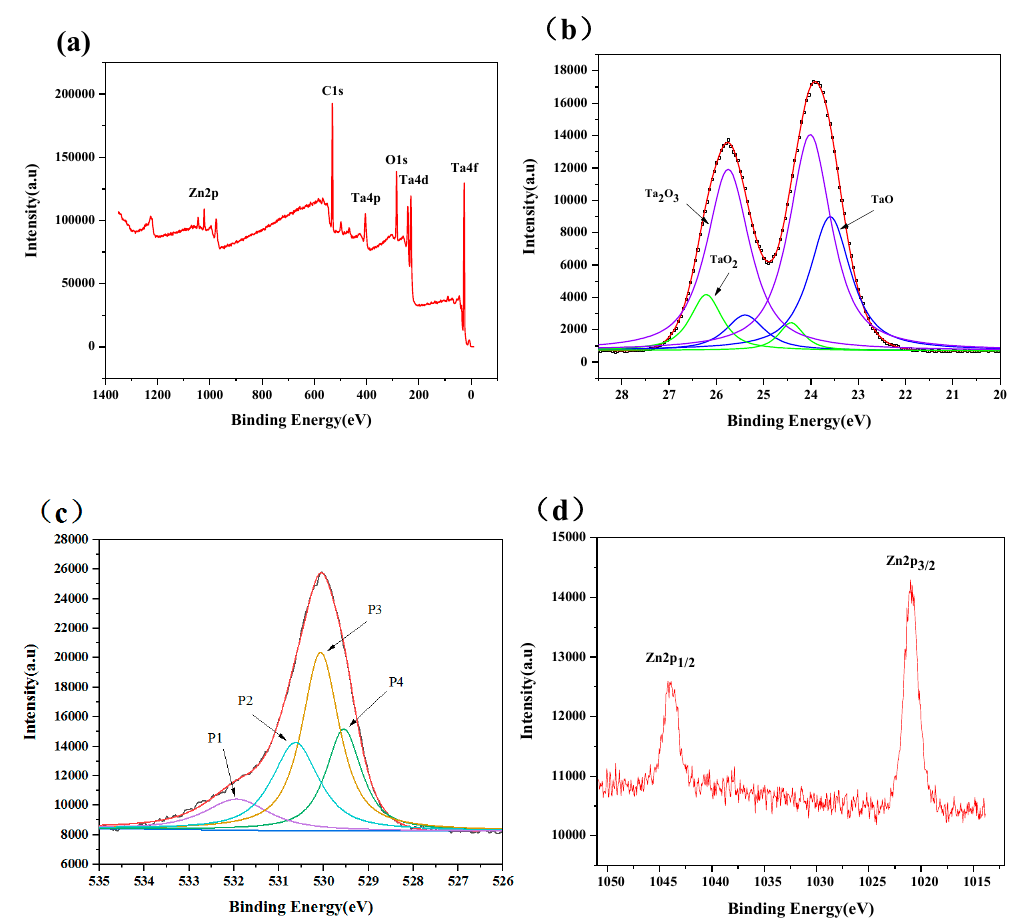
Figure 7. (a) XPS survey spectrum of ZnO-Ta x O y coating and high-resolution spectra of (b) Ta 4f, (c) O 1s, and (d) Zn